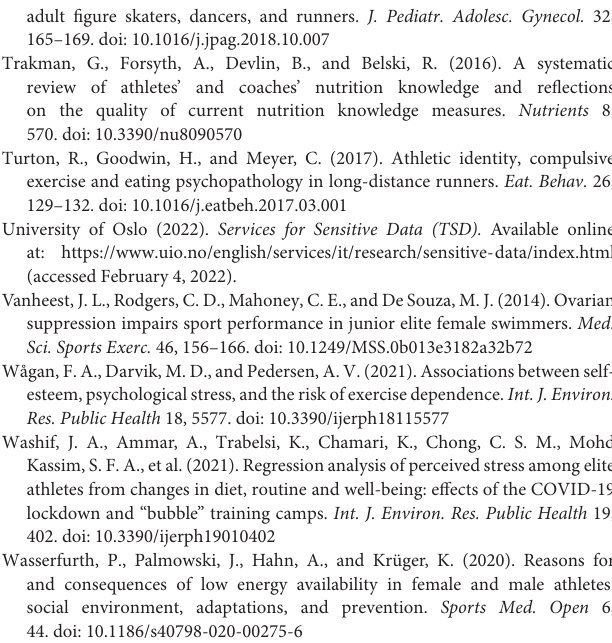
adult figure skaters, dancers, and runners. J. Pediatr. Adolesc. Gynecol. 32, 165–169. doi: